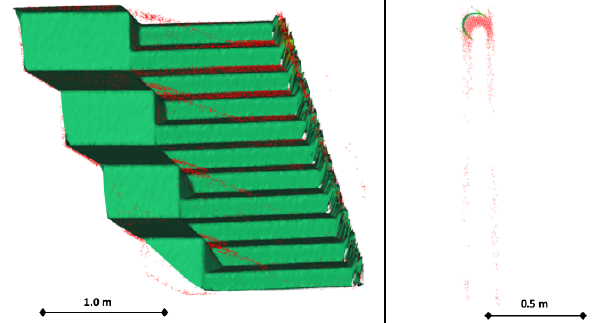
Figure 9. Examples of Beam Divergence Issues with Livox and Ouster Scanners. Green is VZ-2000 data, and red is Livox data. Oblique view of staircase edges on left, and top view of a lightpole on